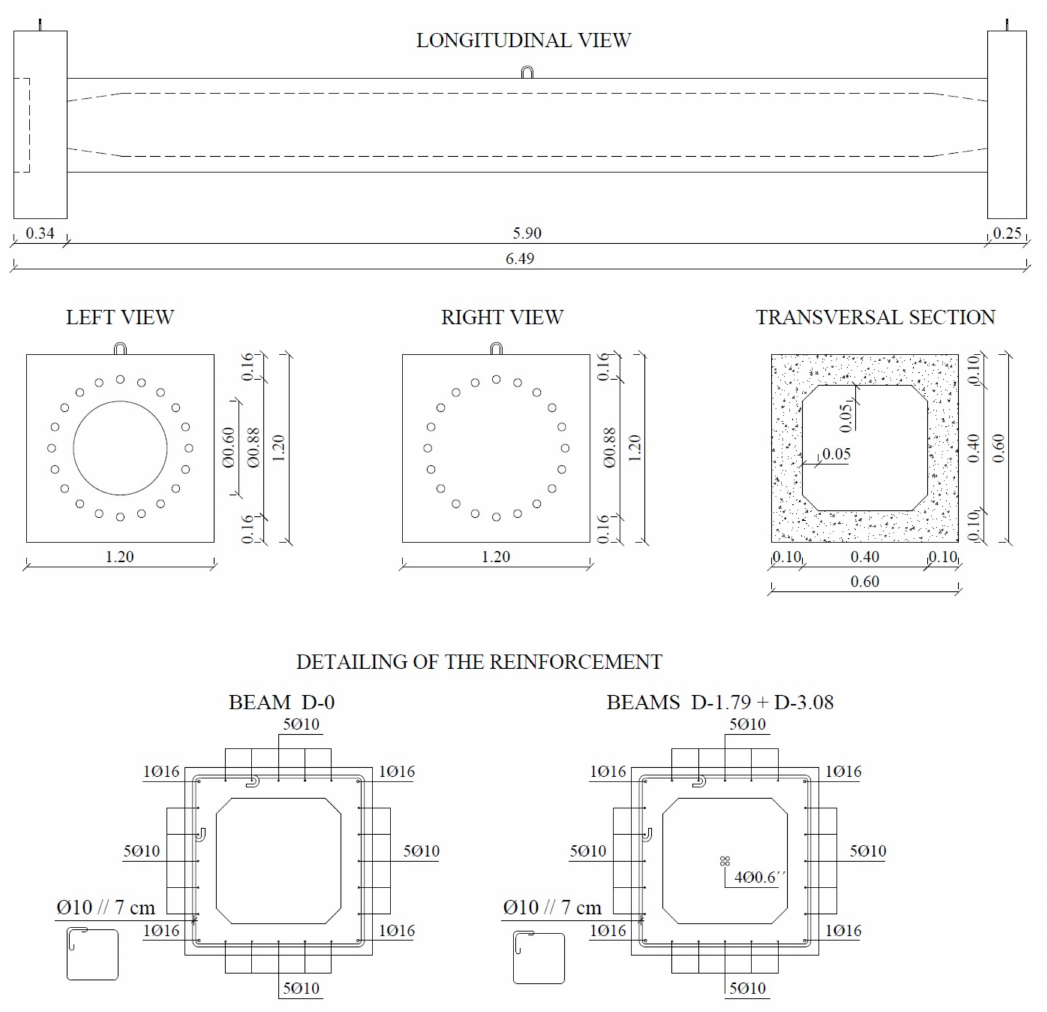
Figure 2. Geometry and detailing of test